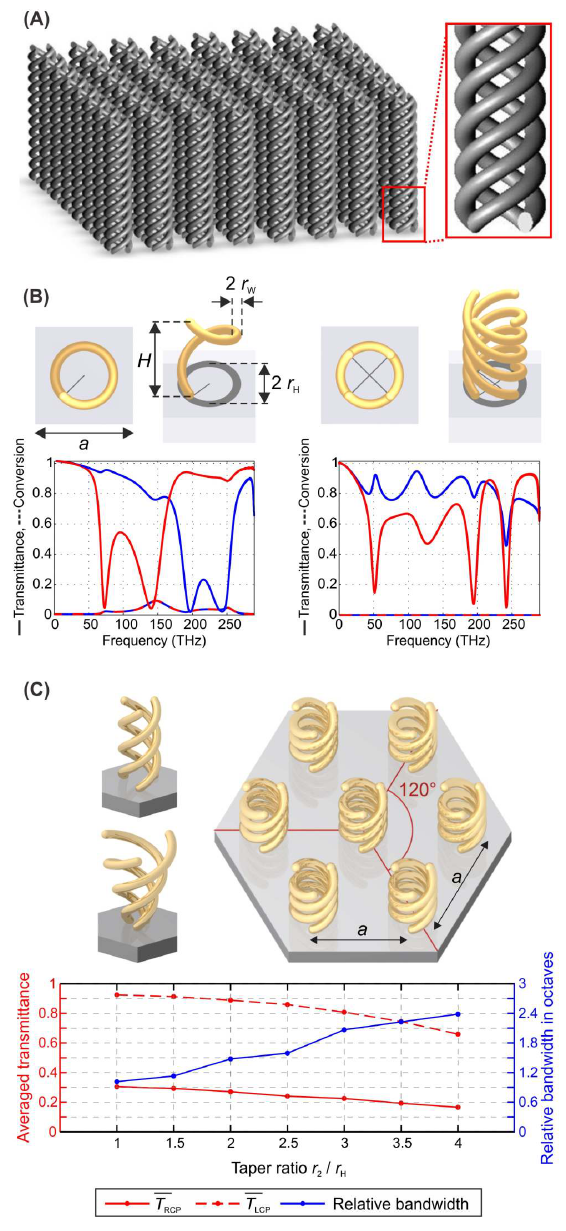
Figure 3: (A) First proposed design with four intertwined aluminum helices (reprinted with permission from [29]. Copyright 2011 OSA). (B) Illustration of single and N = 4 -helices with corresponding numerically calculated transmittance spectra. While conversions (dashed lines) are eliminated in the latter case and the bandwidth is increased, the extinction ratio is strongly deteriorated (adapted with permission from [32]. Copyright 2012 OSA). (C) By arranging N = 3 -helices in a hexagonal lattice, circular polarization con- versions can also be eliminated. By furthermore tapering the helix radius, bandwidth and extinction ratio can be optimized simulta- neously, as depicted in the bottom panel (adapted with permission from [33]. Copyright 2014